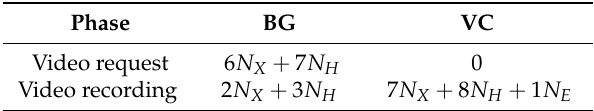
Table 2. Performance of the body gateway (BG) and video camera